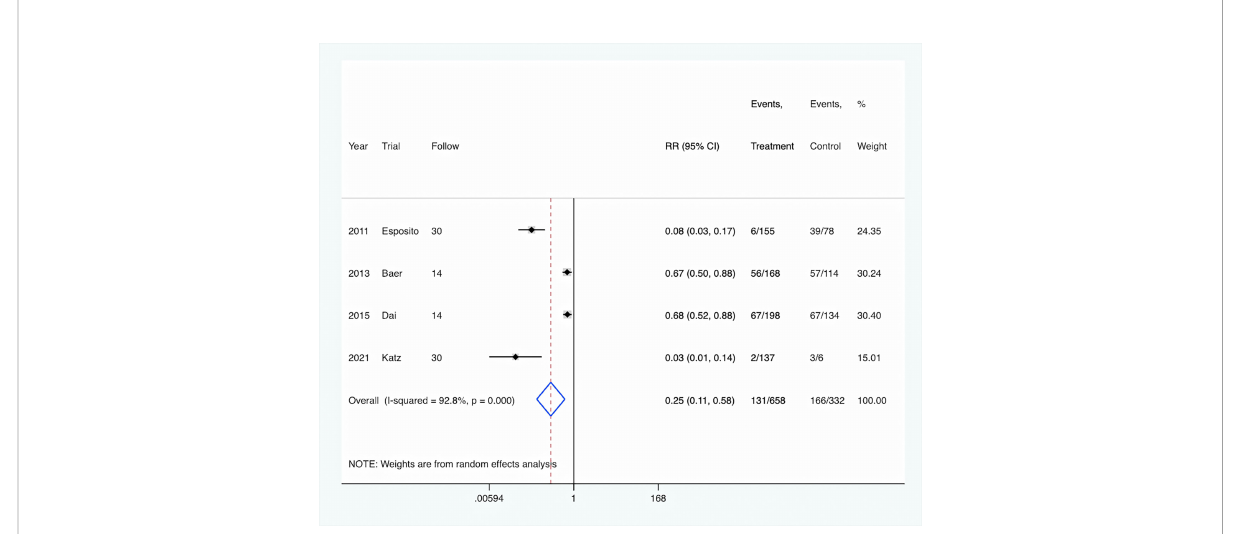
FIGURE 7 PCT-guided treatment was associated with decreased rate of antibiotic adverse event.